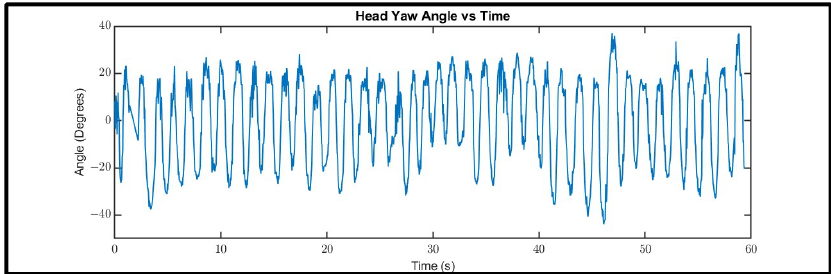
Figure 11. Head yaw motion signal for a 60-s horizontal VORx1 exercise. The head angles oscillate between two extremes, represented by peaks and valleys in the curve. If the head movements are performed uniformly with exactly the same ampli-